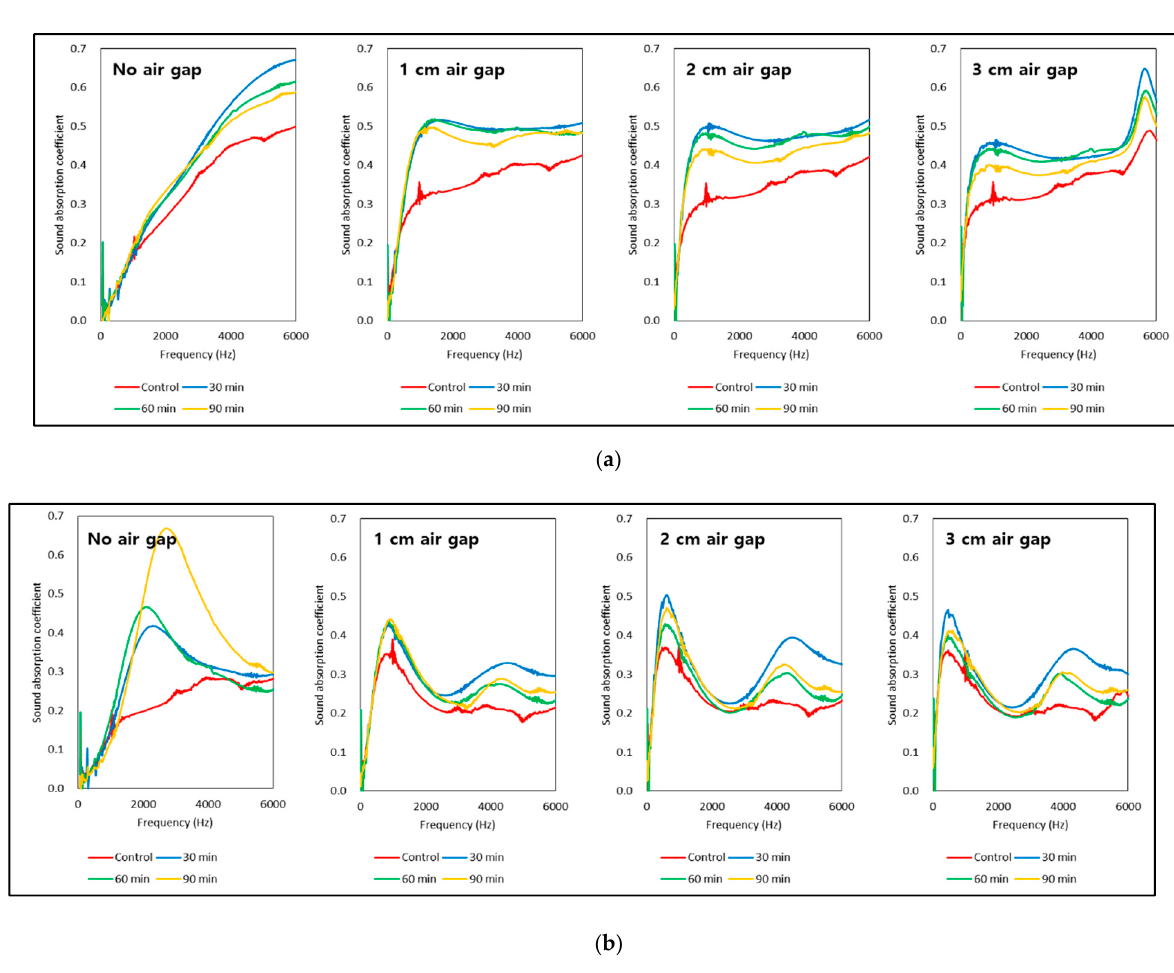
Figure 6. Sound absorption coefficient curve before and after delignification treatment of momala ( a ) and red toon ( b ) wood with an air gap: ( a ) Momala; ( b ) Red toon.